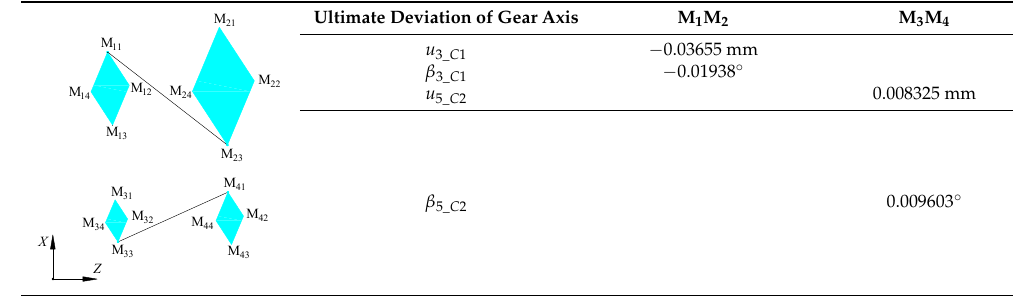
Table 4. Ultimate deviation of angle of intersection and pose expression of gear axis.